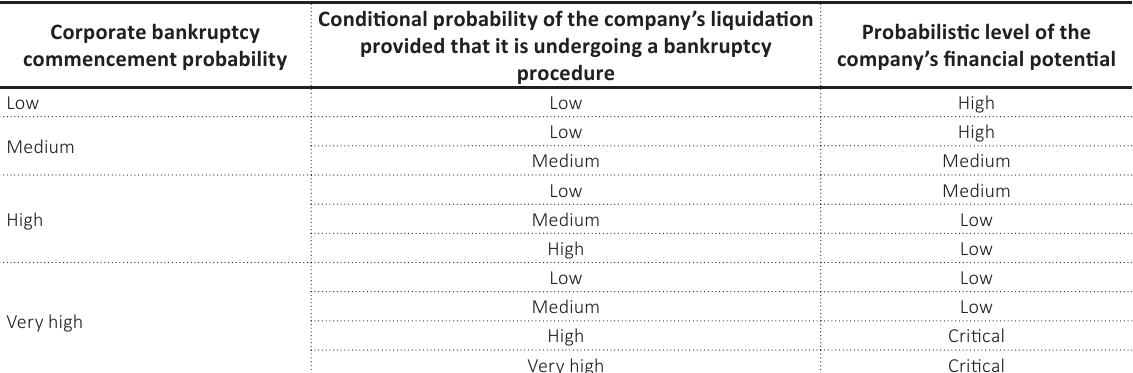
Table 5. Matrix of the pairwise comparison of the qualitative assessment results for the probabilistic level of the financial potential, the corporate bankruptcy commencement probability and the conditional probability of the liquidation procedure commencement provided that the company is undergoing a bankruptcy